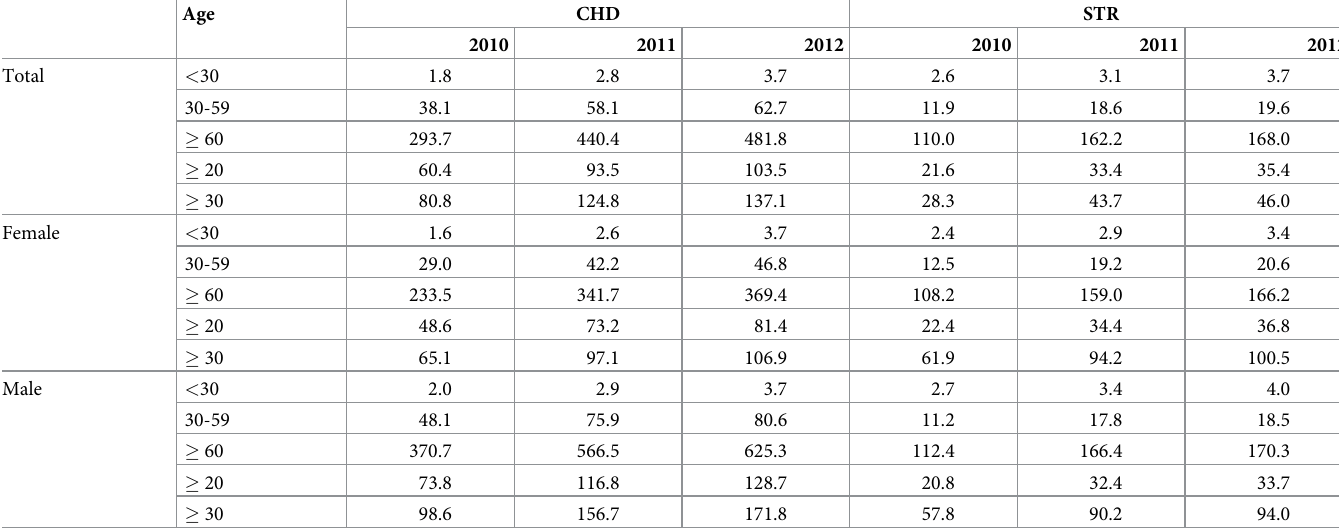
Table 3. Prevalence of CVD (CHD,STR) by age groups (per 10,000 individuals).